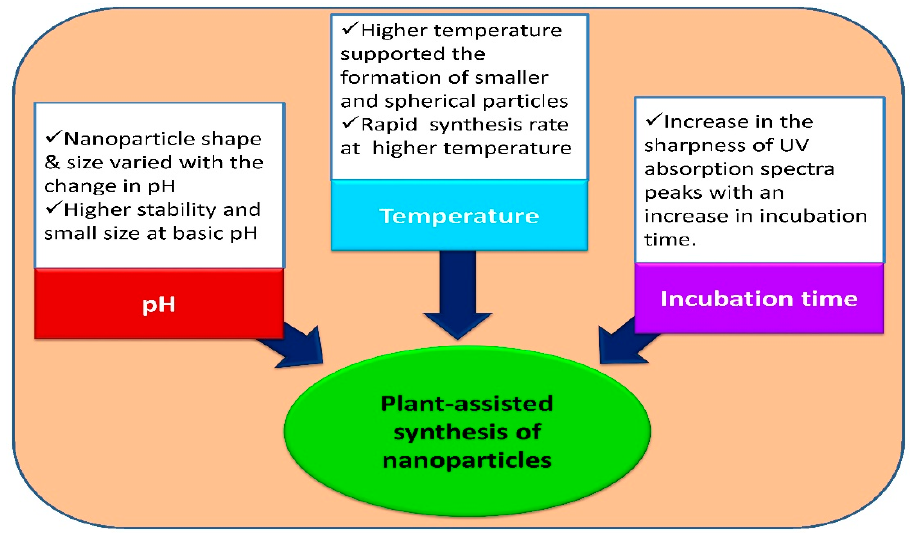
Figure 5. Factors affecting plant-assisted synthesis of